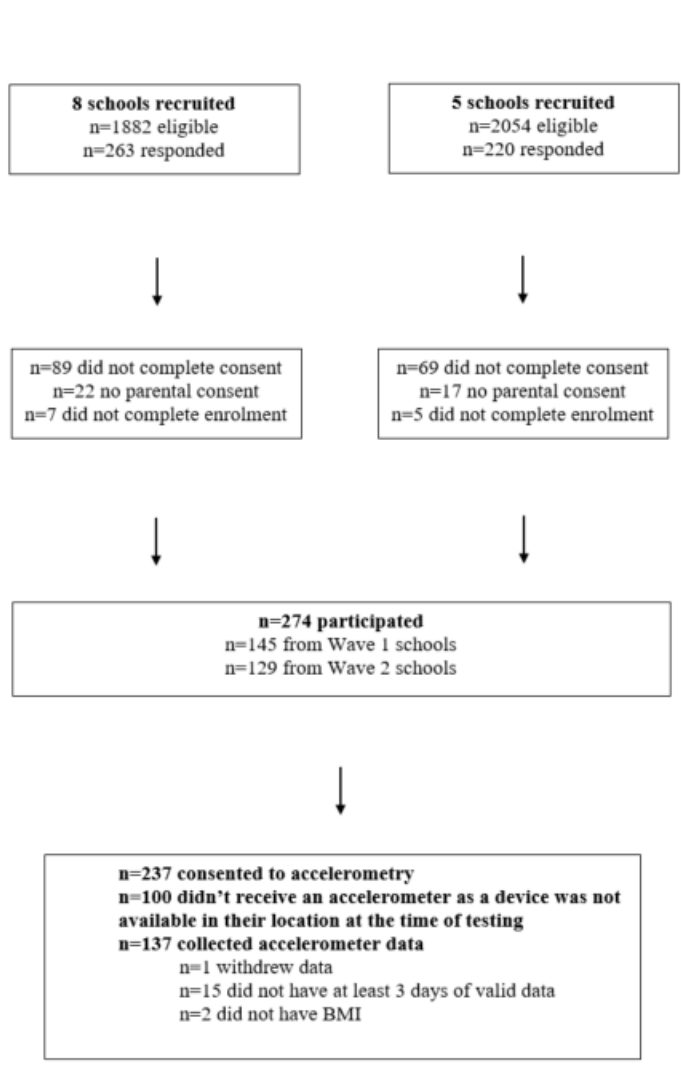
Figure 1. Participant flow.